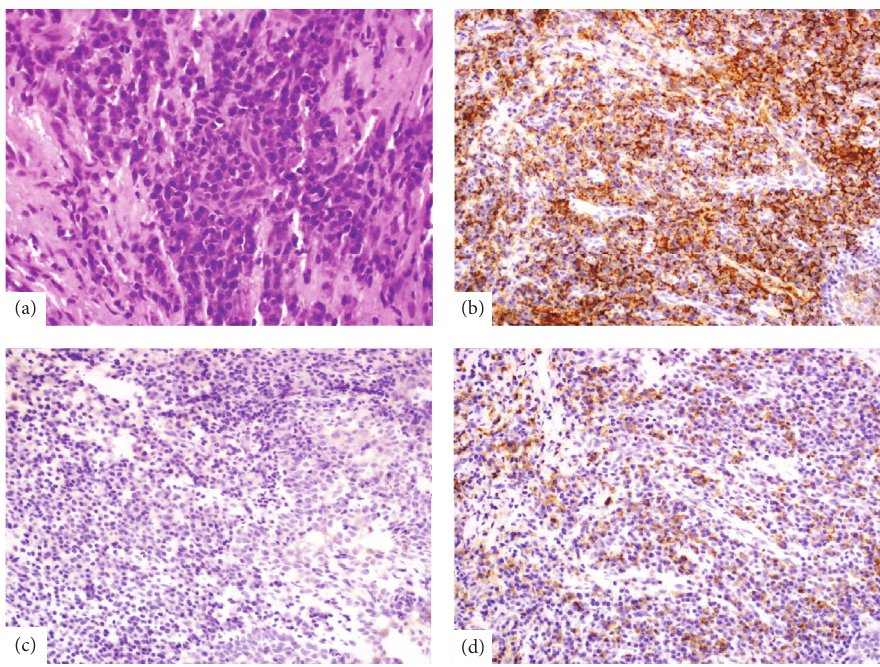
Figure 1: (a) Dense plasma cell infiltrate, H&E, 40x; (b) CD138 immunostain labeling plasma cells, IHC 40x; (c) Kappa in situ hybridization with only rare plasma cell labeling, ISH, 40x; (d) Lambda in situ hybridization with most plasma cells labeling, ISH,